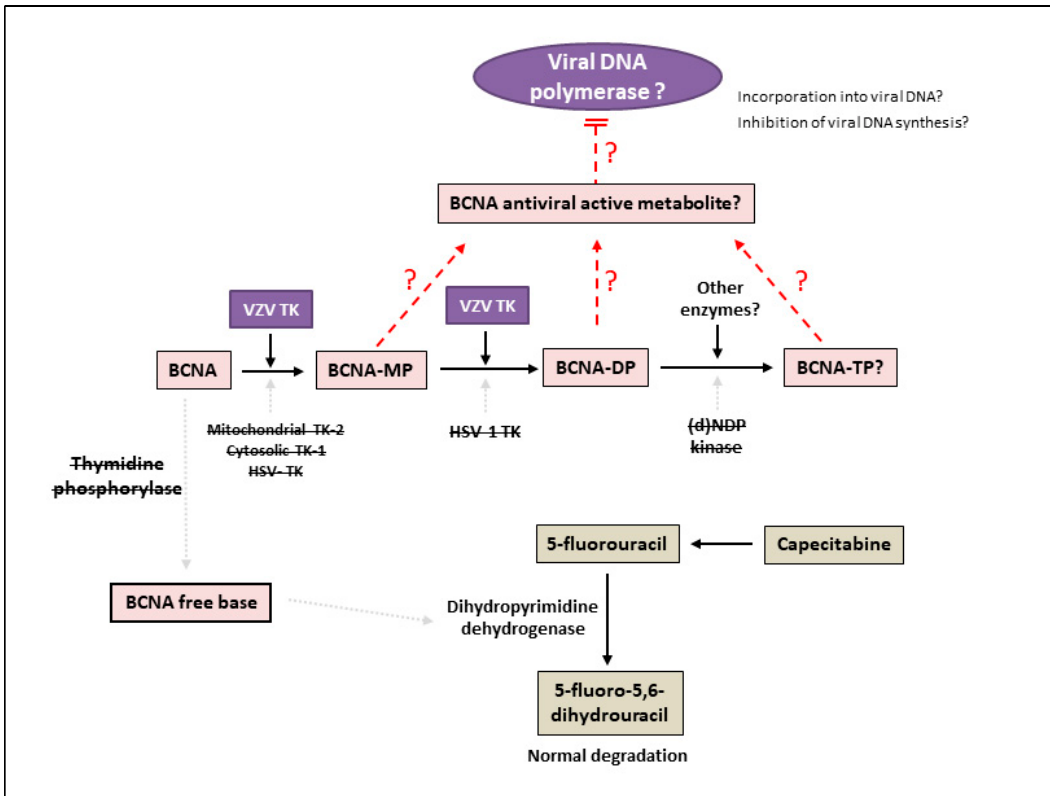
Figure 4. Activation, mechanism of action and catabolism of bicyclic nucleoside analogues (BCNAs). VZV TK converts BCNA’s to the mono ‐ and diphosphate forms although whether there is conversion to the triphosphate form and which is the active metabolite and mechanism of action remain unclear to date. Striking differences between BCNAs and BVDU exist regarding their catabolic pathways. In contrast to BVDU, human TPases do not recognize BCNA’s as substrates and the free bases of BCNAs do not inhibit human DPD (dihydropyrimidine dehydrogenases) and thereof, there is a normal metabolism of Capecitabine/5 ‐ fluorouracyl. Dashed grey arrows indicate lack of activation.